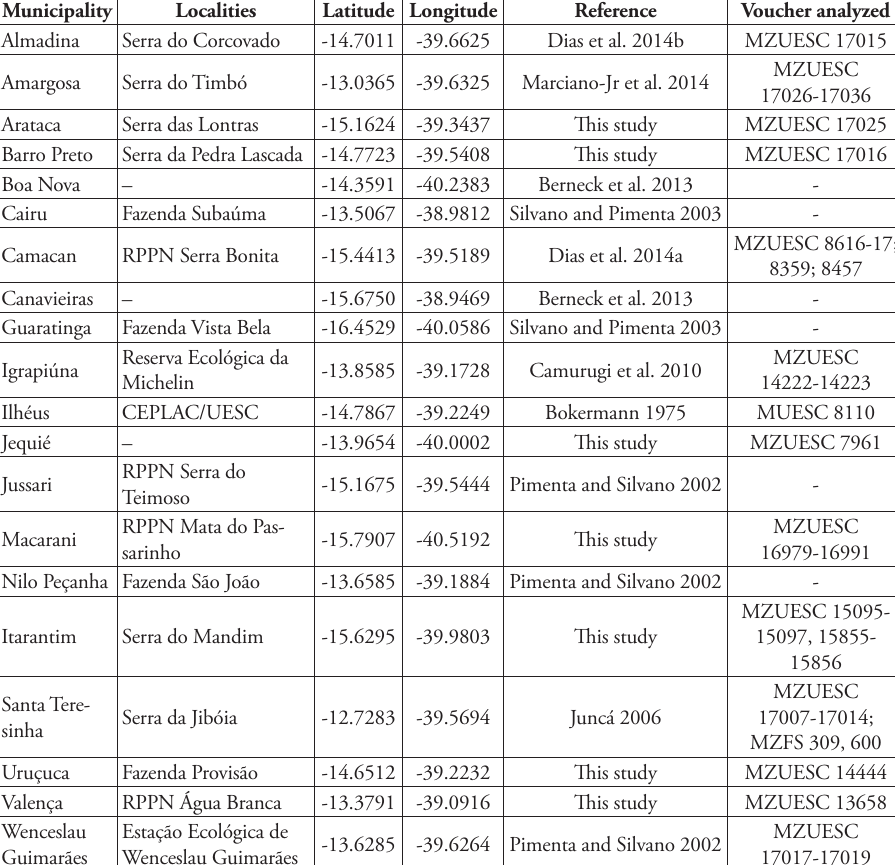
Table 1. Distribution records of Eleutherodactylus bilineatus based on literature review, museum data (MZUESC) and field